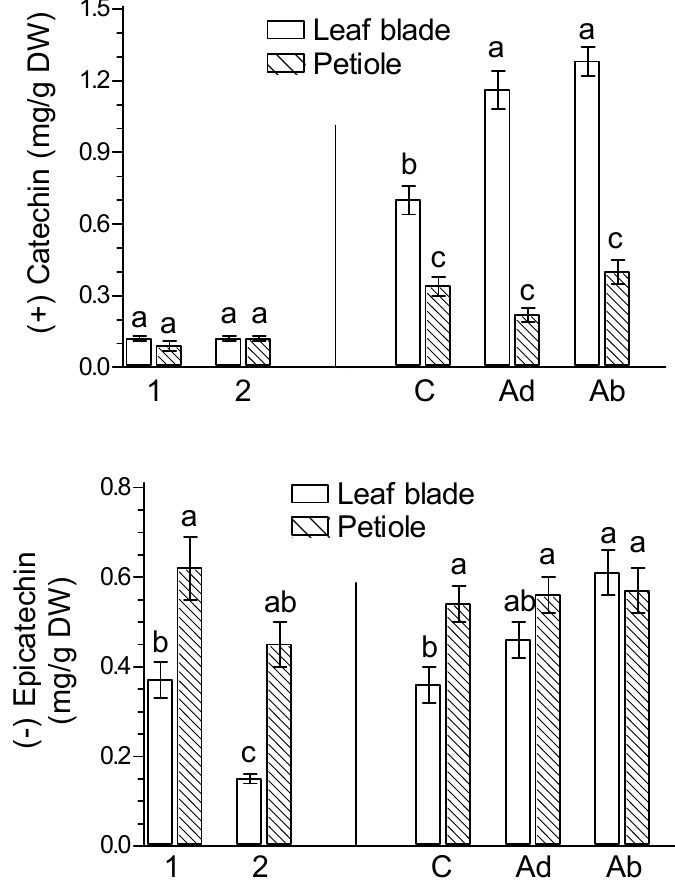
Figure 4. Effect of methyl jasmonate (JA-Me) on the content of (+) catechin and (−) epicatechin in the leaf blade and petiole of G. biloba . Mean results ± SD followed by the same letter calculated for the natural senescence process and JA-Me treatment separately were not significantly different ( p < 0.05) according to Tukey’s test. Description of samples: 1, initial time (9 September); 2, naturally senesced yellow leaves (20 October); C, control (lanolin); Ad, JA-Me applied to the adaxial side of the leaf blade; Ab, JA-Me applied to the abaxial side of the leaf blade. C, Ad, and Ab samples were collected for analysis on 30 September. The levels of apigenin in the leaf blades and petioles of ginkgo leaves varied slightly during natural senescence (Figure 3). However, in naturally senesced yellow leaf organs (Figure 3, marked as 2), luteolin levels were about twice as high as in green leaves (Figure 3, marked as 1). The level of (+) catechin in the leaf blades and petioles of G. biloba was almost the same as in green leaves (Figure 4, marked as 1) and naturally senesced yellow leaves (Figure 4, marked as 2). In contrast, the levels of (−) epicatechin in the leaf blades and petioles of naturally senesced yellow leaves (Figure 4, marked as 2) were much lower than those in green leaves (Figure 4, marked as 1). This suggests that endogenous levels of flavonoids are affected differently by natural leaf senescence processes. Irrespective of the application side, JA-Me did not affect the endogenous levels of quercetin in petioles, but JA-Me applied to the Ad side of leaf blades increased its level in the leaf blades (Figure 2). In contrast, JA-Me applied to the Ad side increased endogenous levels of quercetin 4-glucoside in the leaf blades more compared to JA-Me applied to the Ab side. For rutin, JA-Me applied to the Ab side increased its level relative to control leaf blades, whereas JA-Me applied to the Ad side decreased its content. The levels of the flavones apigenin and luteolin in Ginkgo leaf organs were low (Figure 3). JA-Me applied to the Ad and Ab sides increased the levels of both flavones in leaf blades. However, the increase in the apigenin content by JA-Me applied to the Ab side was significant. In petioles, the application of JA-Me to the Ab side had some effect but tended to decrease luteolin levels. As flavan-3-ols, the levels of (+) catechin in control leaves was much higher in leaf blades than in petioles. In contrast, the levels of (−) epicatechin were higher in petioles than in leaf blades (Figure 4). The application of JA-Me to the Ad and Ab sides almost doubled the levels of (+) catechin in leaf blades. In the case of (−) epicatechin, only JA-Me applied to the Ab side caused this phenomenon. Both methods of treatment of G. biloba leaves did not affect the contents of (+) catechin and (−) epicatechin in the petiole. Among the phenolic acids, ester derivatives of caffeic acid and ferulic acid as well as p -coumaric acid esters and glycosides were found. The level of p -coumaric acid glyco- sides in leaf blades and petioles was about 10 times higher than their ester form. How- ever, no free forms of phenolic acids were found (Figure 5). There were clear differences